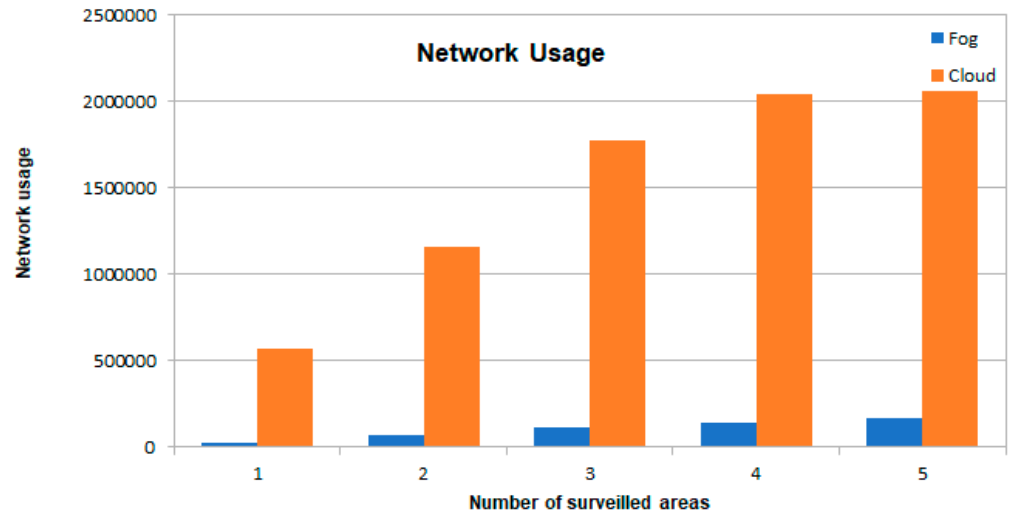
Figure 3. Network usage by fog and cloud platforms (in Bytes).